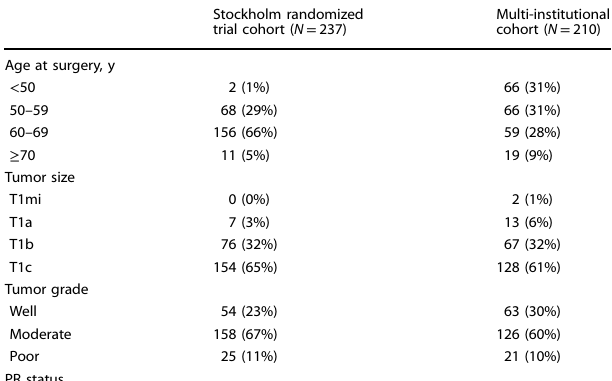
Table 1. Patient demographics and baseline characteristics for patients with T1N0 hormone receptor – positive breast cancer from the Stockholm randomized trial and multi-institutional cohorts Stockholm randomized trial cohort ( N = 237)